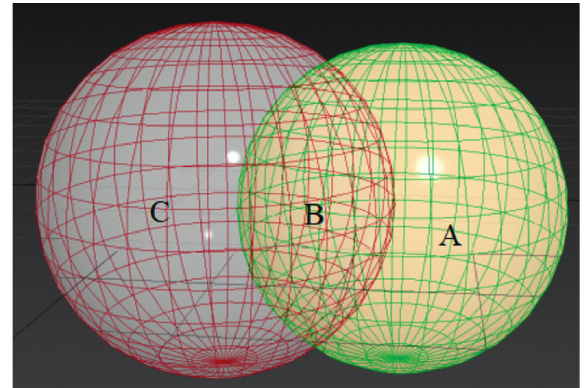
Figure 10: Special